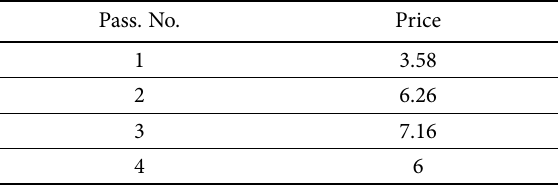
Fig. 4. The illustration of case No.